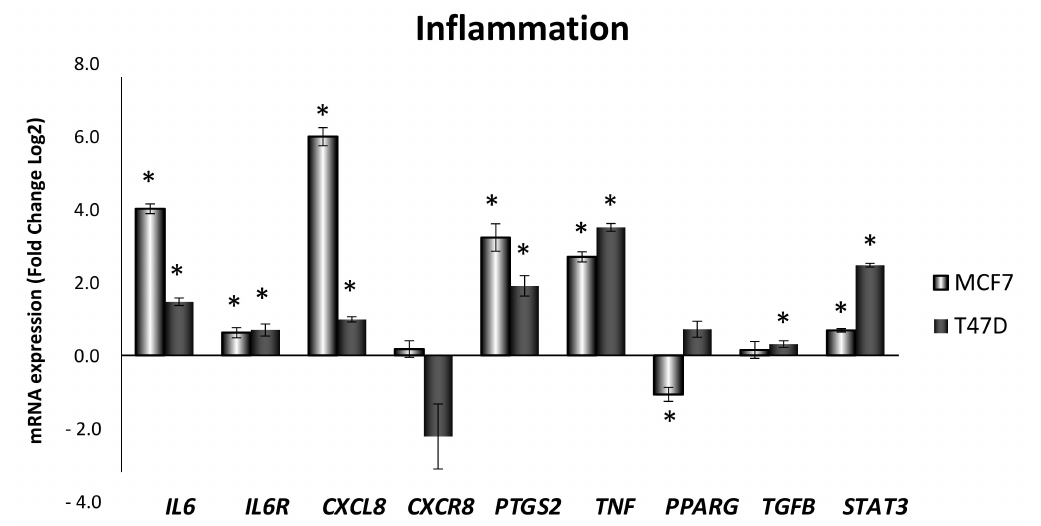
Figure 1. Obesity-related inflammation treatment increased the expression of genes related to inflammation in MCF7 and T47D breast cancer cell lines. IL6 : interleukin-6; IL6R : interleukin-6 receptor; CXCL8 : interleukin-8; CXCR8 : interleukin-8 receptor; PTGS2 : cyclooxygenase-2; TNF , tumor necrosis factor alpha; PPARG : peroxisome proliferator-activated receptor gamma; TGFB : transforming growth factor beta; STAT3 : Signal transducer and activator of transcription 3 . Breast cancer cells were incubated for 24 h with vehicle (DMSO) or ELIT. Data are represented as fold change (log2) of mRNA expression with respect to vehicle-treated cells, set at 0, of each cell line. Data represent means ± SEM ( n = 6). * Statistically significant difference between ELIT treated and vehicle-treated cells (Student’s t -test, p <